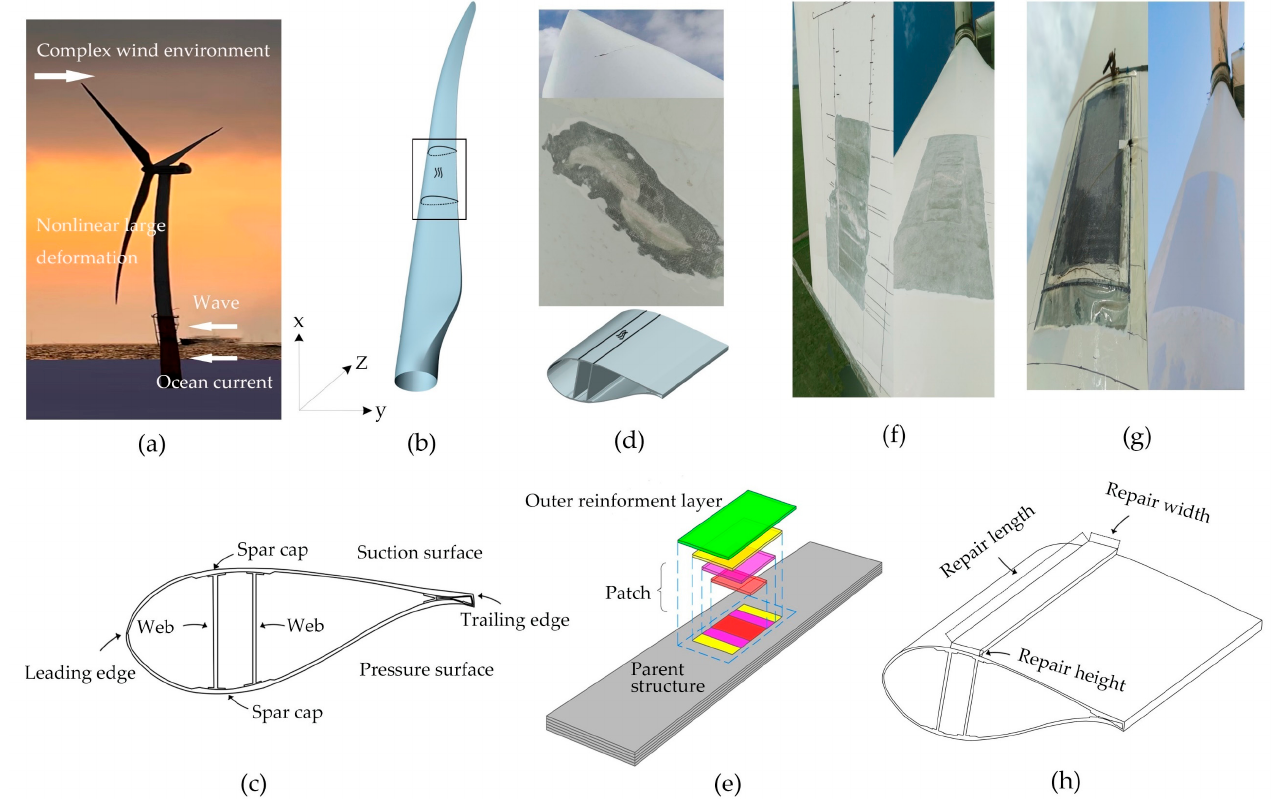
Figure 1. Damage repair design of offshore WT blades structures: ( a ) nonlinear deformation of blades in complex offshore wind environments; ( b ) spar cap damage of full-size blades; ( c ) blade cross-section structure; ( d ) blade profiles; ( e ) implementation of stepped-lap scarf repair method under high altitude operation; ( f ) schematic diagram of repair patch and ORLs; ( g ) repair process; ( h ) design of repair parameters for ORLs.